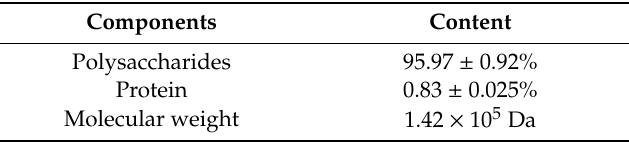
Table 3. The chemical composition of PBE.